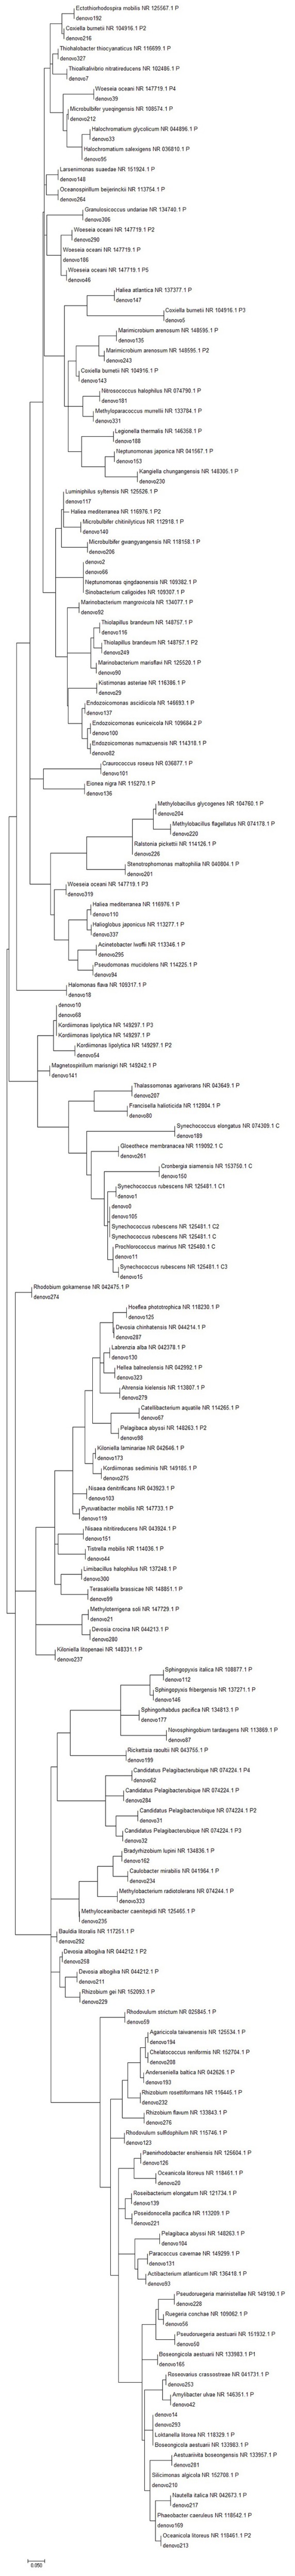
Molecular phylogenetic analysis of Cyanobacteria (red color) and proteobacteria (blue color) phyla in sponge samples based on the bacterial 16S rRNA gene in GenBank. Tree topology constructed using Maximum Likelihood method, with bootstrap values >90%. Scale bar: 0.06 substitutions per nucleotide position.